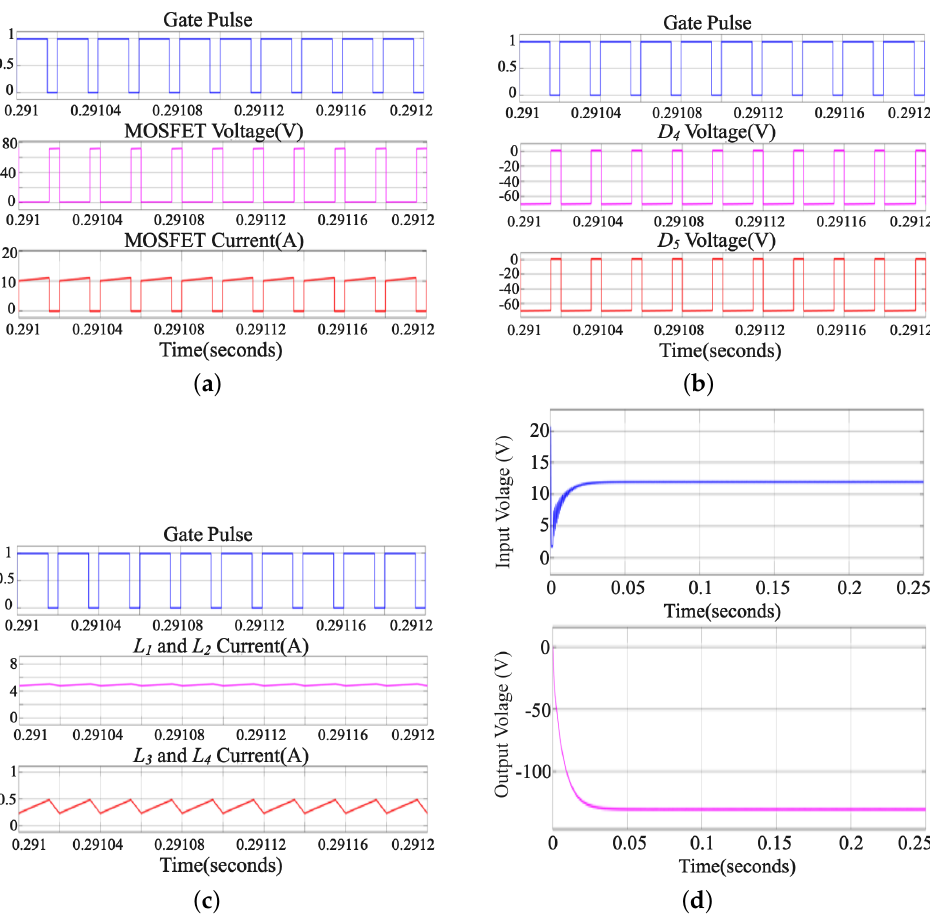
Figure 12. Simulation results of topology 3: ( a ) voltage and current of MOSFET ( b ) voltage across diodes ( c ) inductor’s current ( d ) input and output voltage.